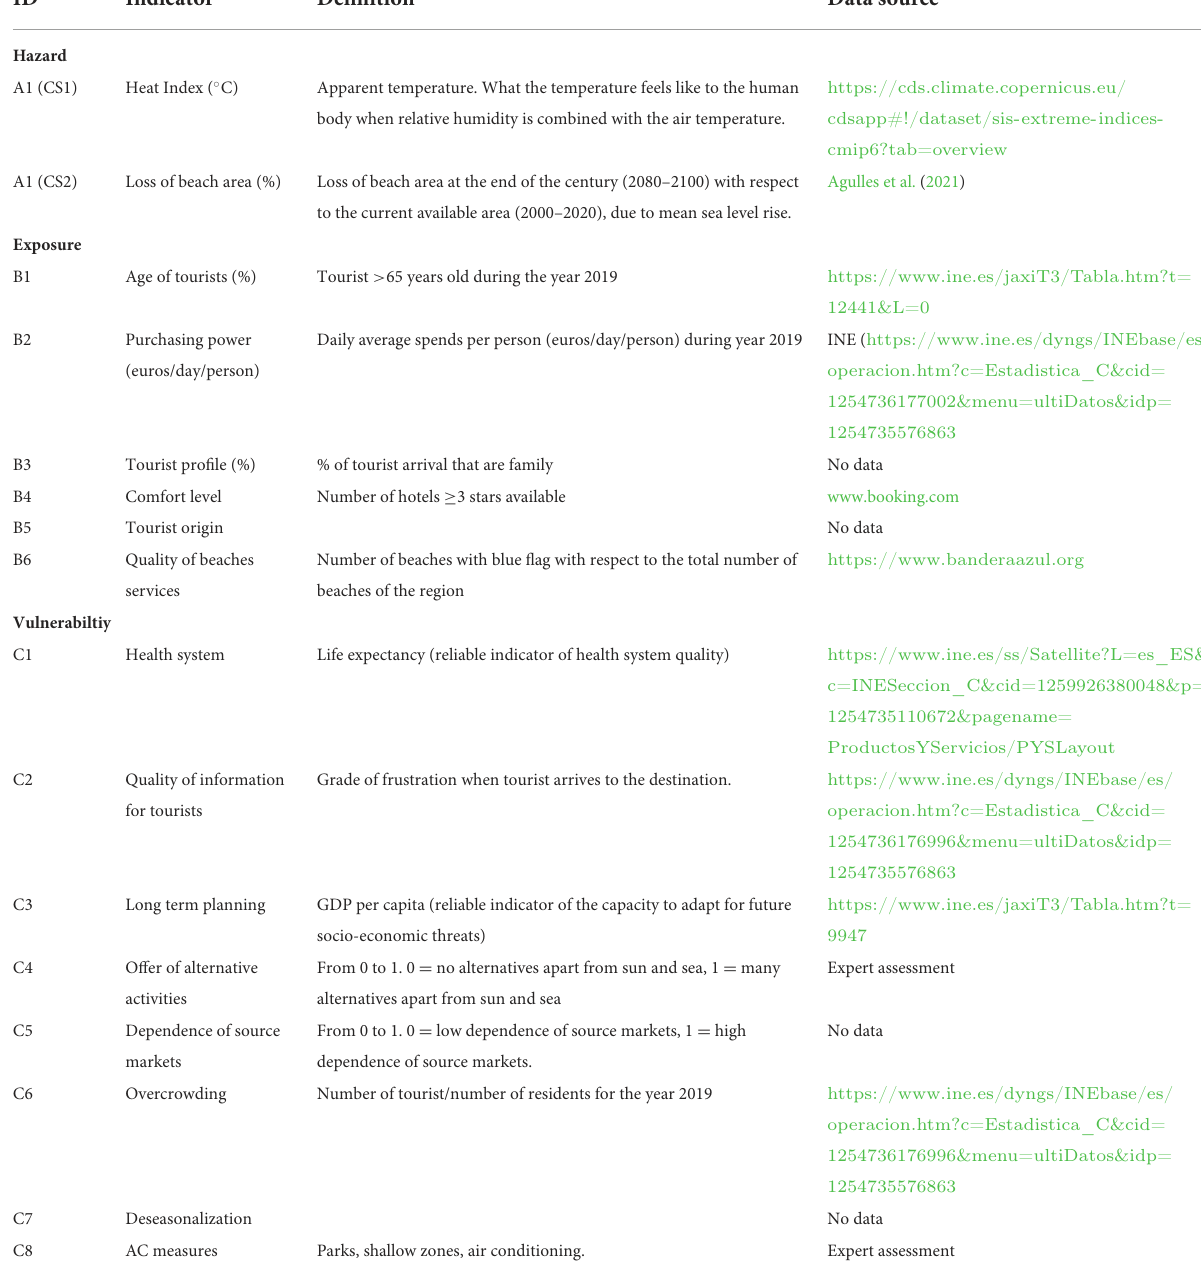
TABLE 1 Overview of the indicators selected for the impact